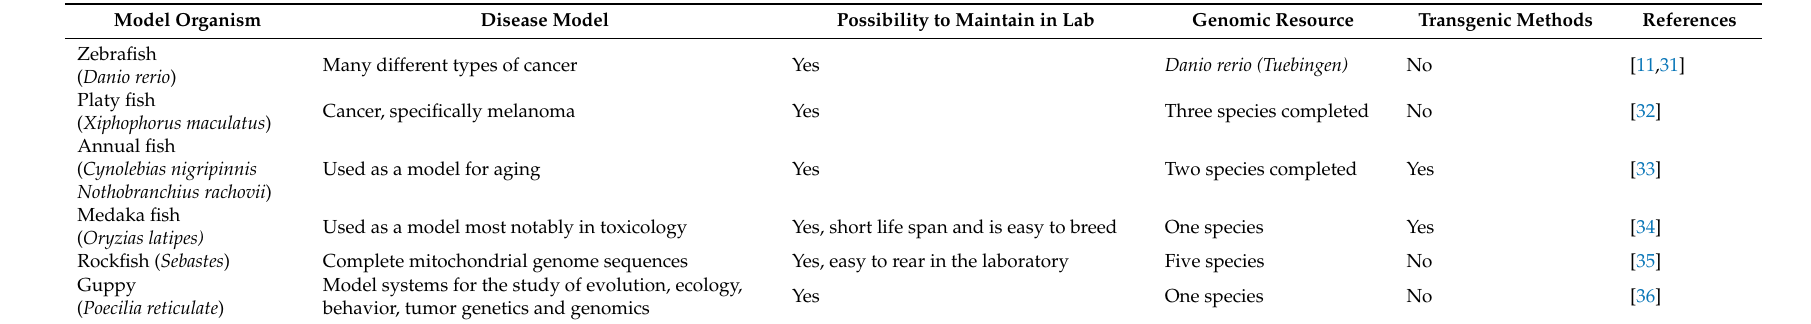
Table 2. The present fish as a model completed genome sequence (the model fish genome is currently being fully